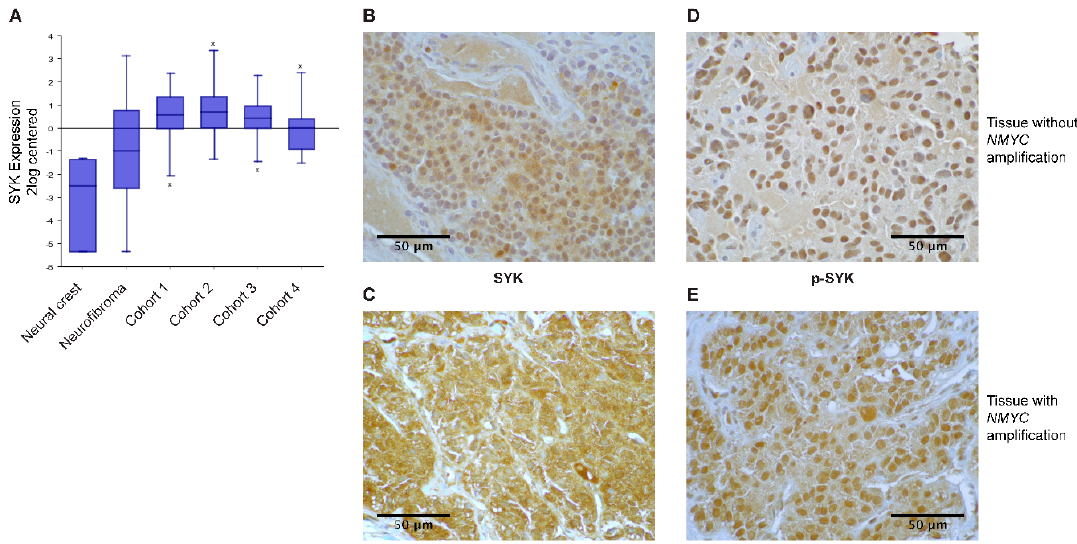
Figure 1. SYK is expressed in neuroblastoma tissue. Gene expression data were analyzed using the R2 database http://r2.amc.nl. ( A ) The expression of SYK was compared between neural crest (Etchevers n = 5), benign neurofibroma (Miller n = 86) and 4 neuroblastoma cohorts (cohort 1: Versteeg n = 88, cohort 2: Delattre n = 64, cohort 3: Hiyama n = 51, cohort 4: Lastowska n = 30). The presence of SYK protein ( B , C ) and phosphorylation at Tyr525 ( D , E ) were determined in neuroblastoma primary tissue using immunoperoxidase staining. ( B , D ) display a staining of a non- MYCN -amplified tumor and ( C , E ) show a MYCN -amplified tumor. Images were captured at a magnification of 900 × . The displayed images are representative stainings from a panel of neuroblastoma tumors. Table 1. Presence of SYK and p-SYK (Tyr525) in neuroblastoma tumor tissue. Neuroblastoma Subgroups SYK Positive (Sections Examined) p-SYK Positive (Sections Examined)